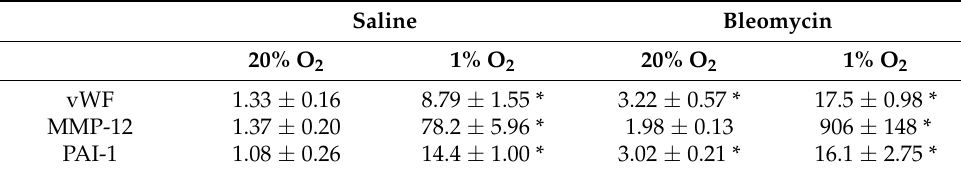
Table 1. Relative mRNA levels associated with endothelial cell damage.